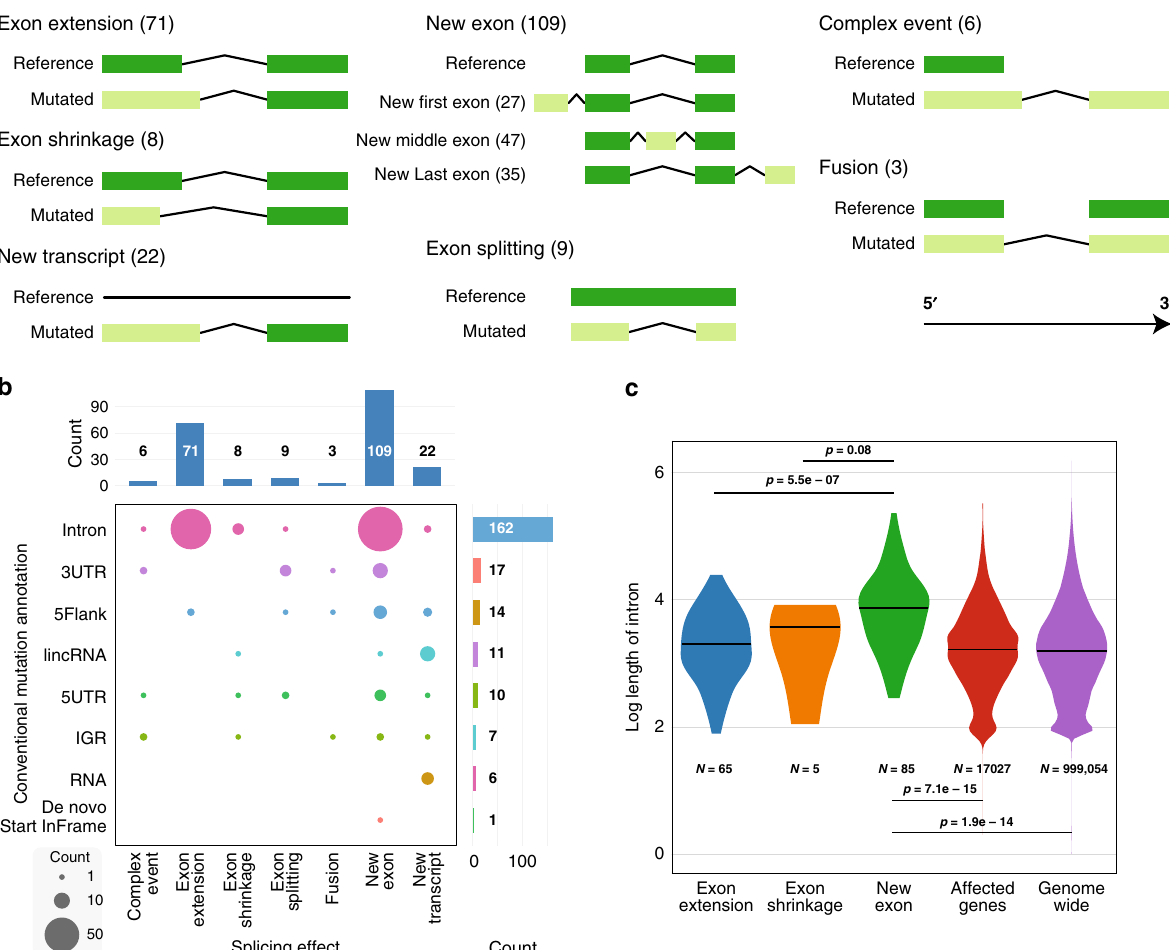
Fig. 2 Category and distribution of nc-SCMs from TCGA WGS data. a Schematics and counts of mutation-induced splicing events in seven different classi fi cations. The new exon category is subdivided into fi rst, middle, and last, depending on the location of the new exon. The complex event is a combination of multiple events, for example, exon extension and new exon. b Types and counts of splice forms in different non-coding regions. c Distribution of intron sizes (log 10 scale) across different categories. The p value is from the Wilcoxon ’ s rank-sum test, two-sided. Source data are provided as a Source Data fi